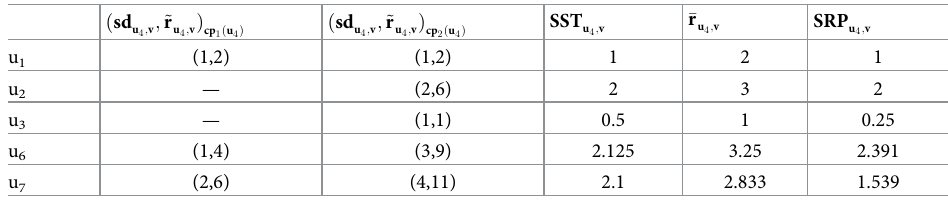
Table 1. The recommendation instance of target user u 4